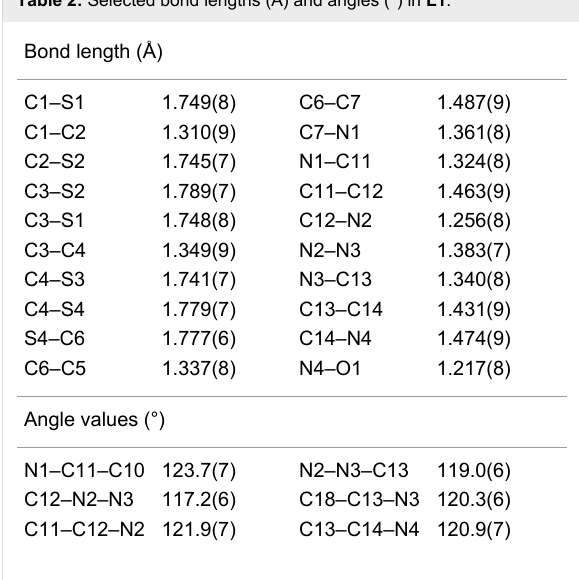
Table 2: Selected bond lengths (Å) and angles (°) in L1